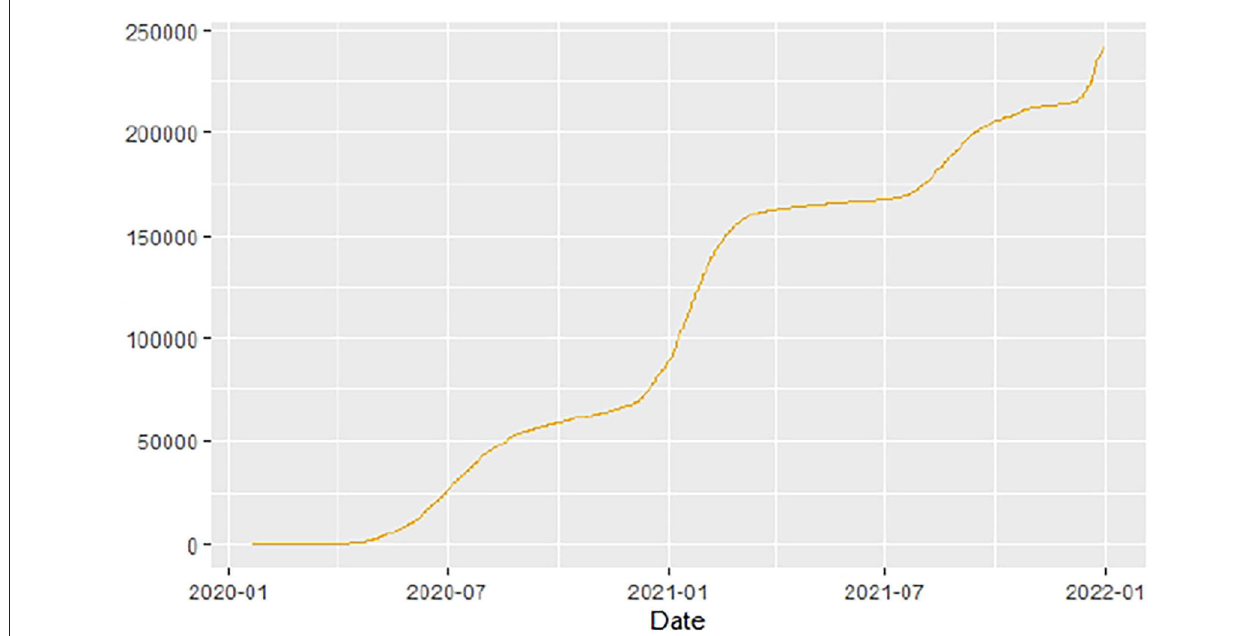
FIGURE 7 | Nigeria cases.